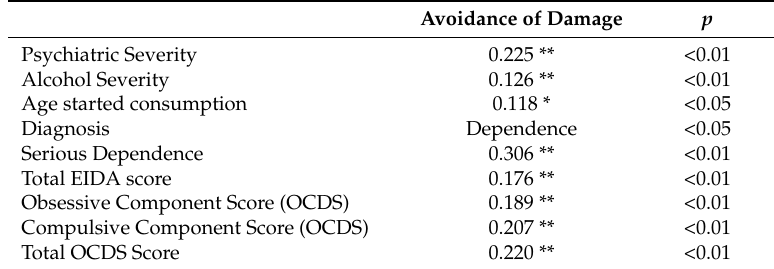
Table 2. Statistically significant correlations between Avoidance of Damage (TCI-R) and severity factors of the EIDA, OCDS and EuropAsi scales. (* p < 0.05; ** p < 0.001).